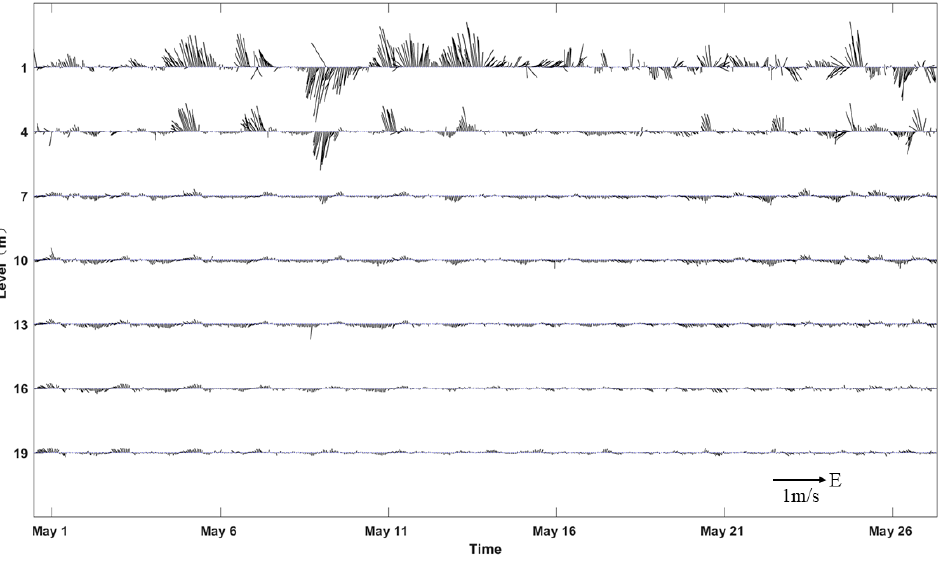
Figure 8. Time series of vertical currents.